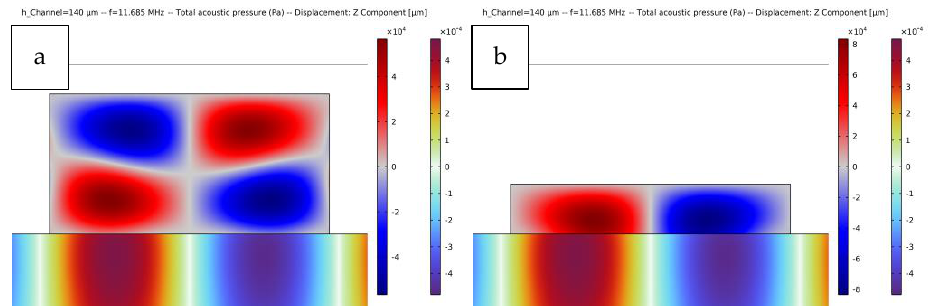
Figure 3. Standing pressure wave distribution in the microchannel ( a ) 140 µm and ( b ) 50 µm thick.